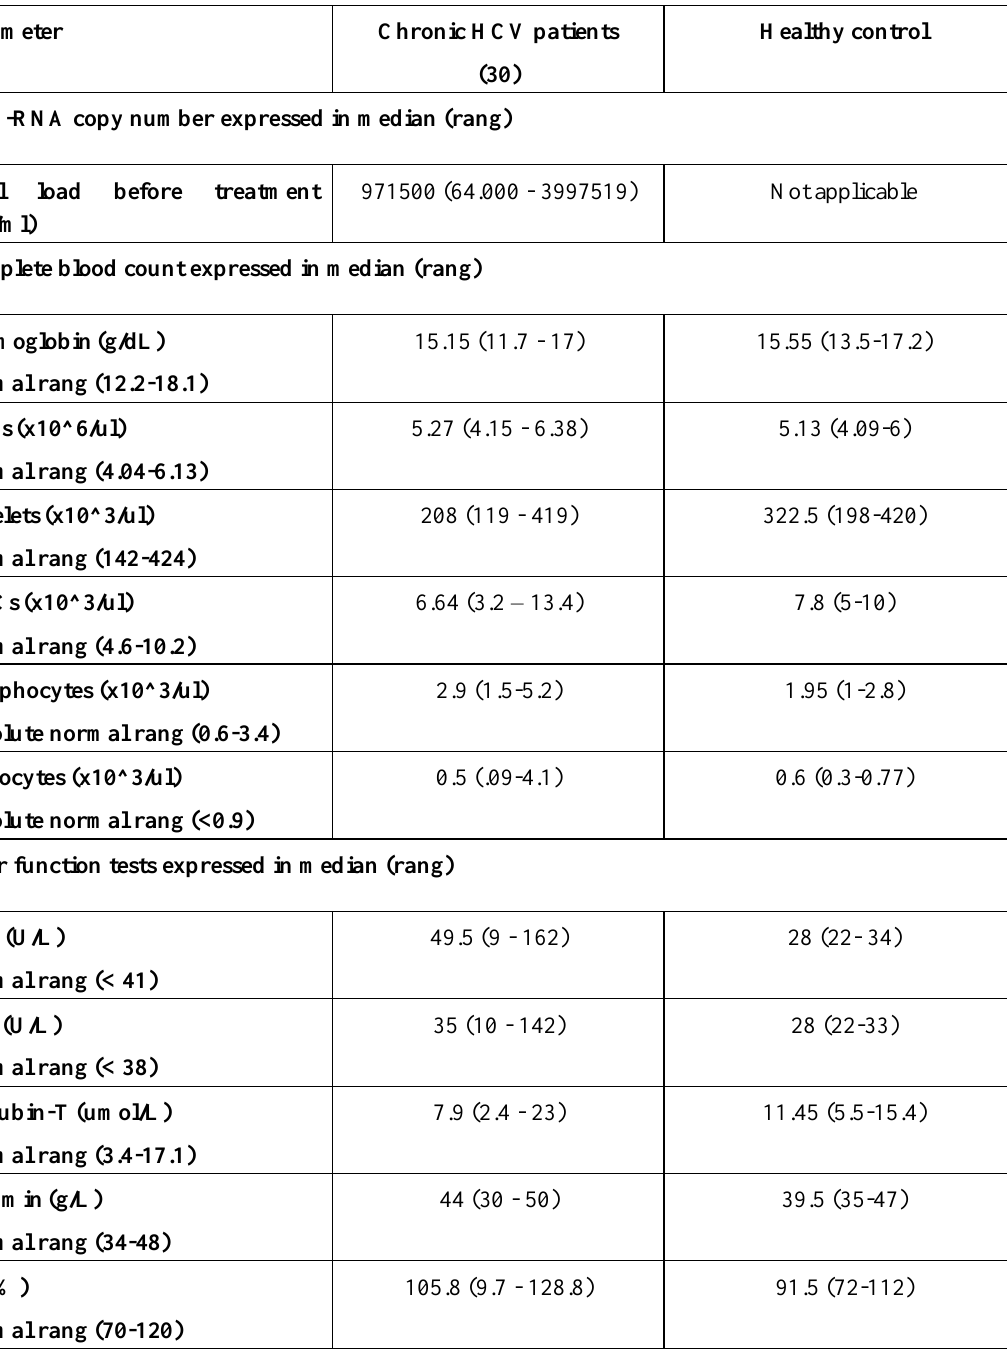
Table 1. laboratory characteristics of chronic HCV patients and control